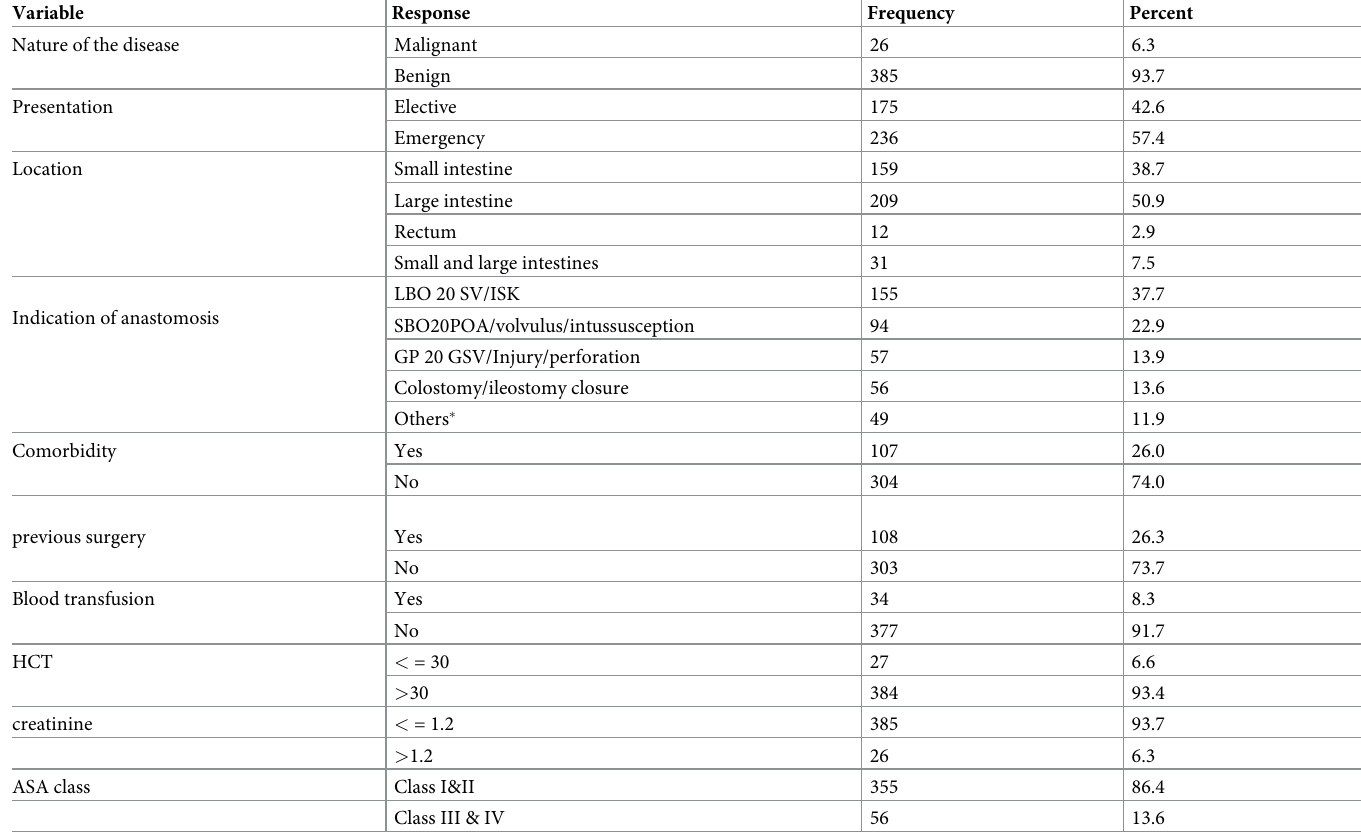
Table 2. Pre-operative status of the patient related characteristics among patients who had intestinal anastomosis surgery in Northwest Amhara regional State referral Hospitals, from February 2017 to February 2020. (n =